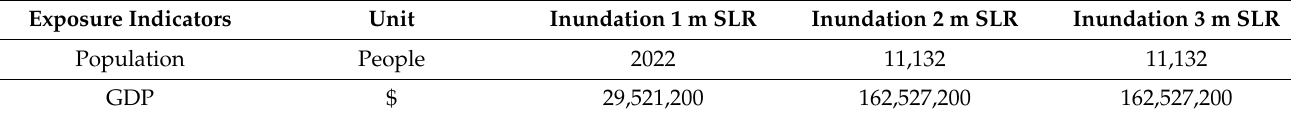
Table 3. SLR impacts on population and GDP